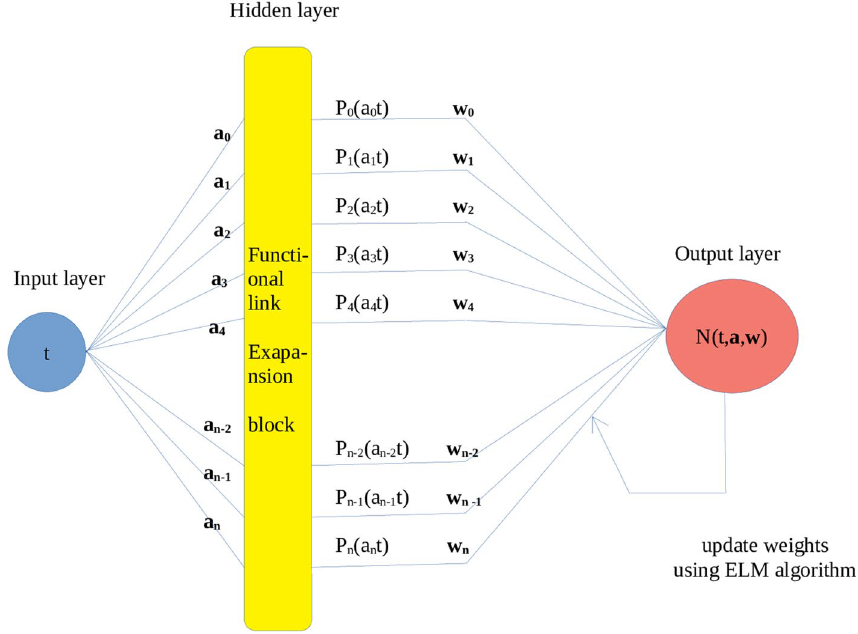
Figure 1. The structure of orthogonal neural